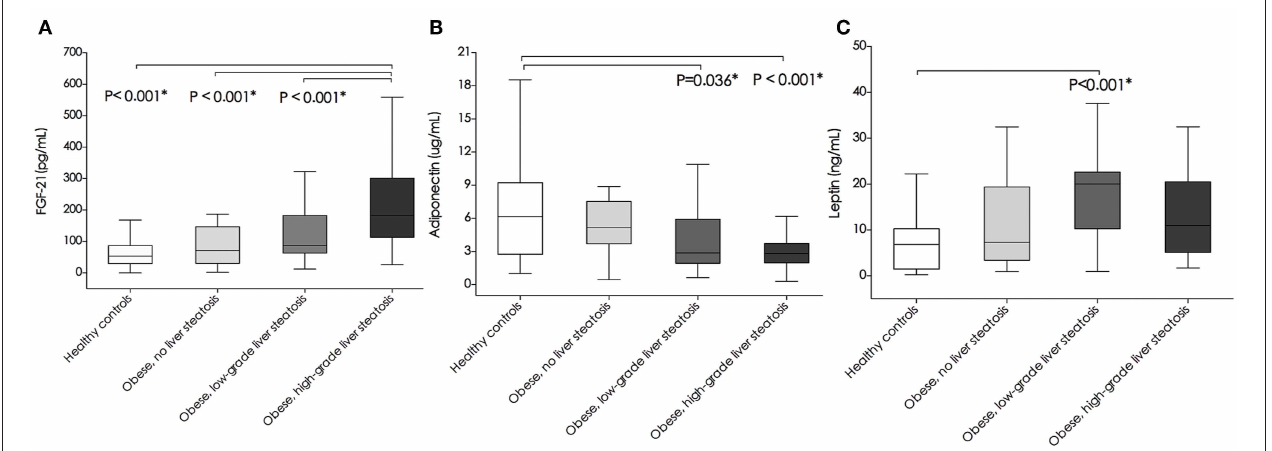
FIGURE 1 | Comparison of plasma (A) fibroblast growth factor-21(FGF-21) levels (pg/mL), (B) adiponectin levels (ug/mL), and (C) leptin levels (ng/mL) between healthy controls, simple obese, and obese children with low-grade and high-grade liver steatosis. Box plots are shown as medians along with interquartile ranges. The differences between two study groups were estimated using Mann-Whitney U test. * P -values < 0.05 were considered statistically significant.